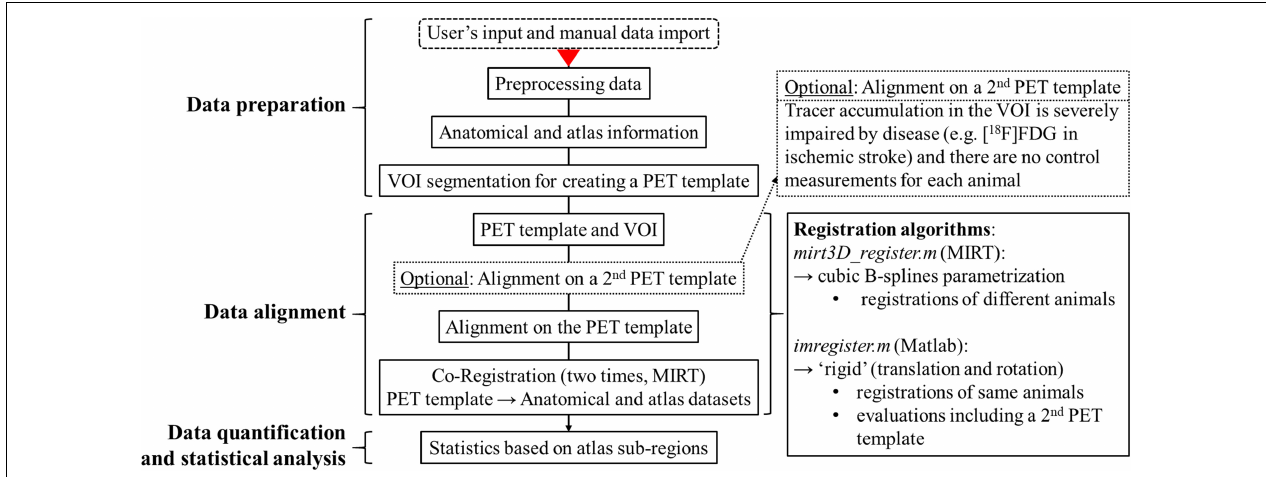
FIGURE 1 | Flow chart of the structure and processing steps of the data analysis tool NU_DPA. The red arrow marks the processing step from which the NU_DPA tool runs automatically.